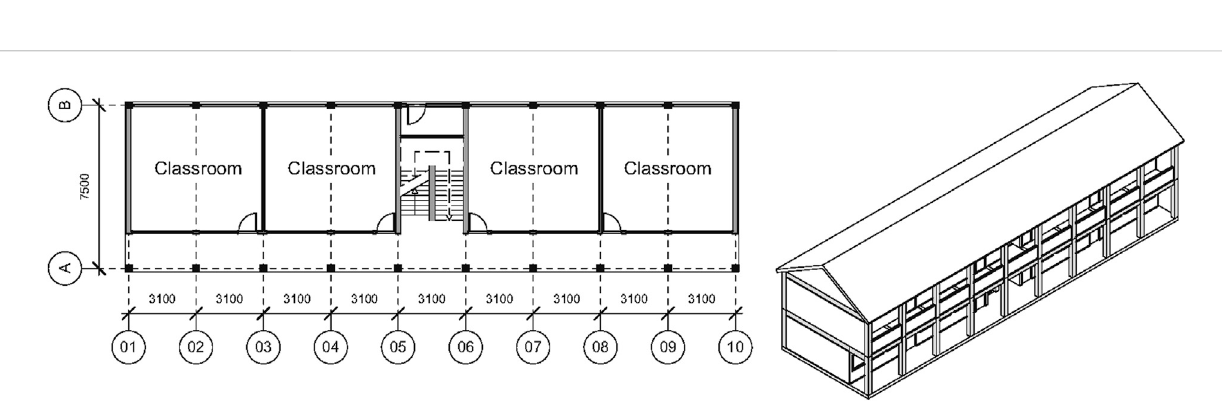
FIGURE 5 Type 1, (A) ground fl oor plan; (B) two-storey 3D view